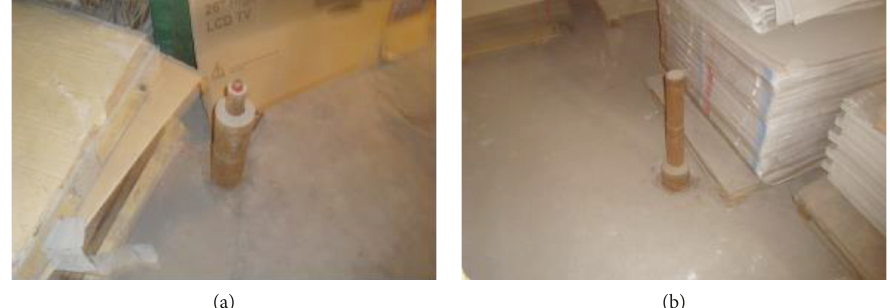
Figure 5: Hierarchical signs in the Changzhou Qingliang primary school. Table 3: The thickness of soil layers.